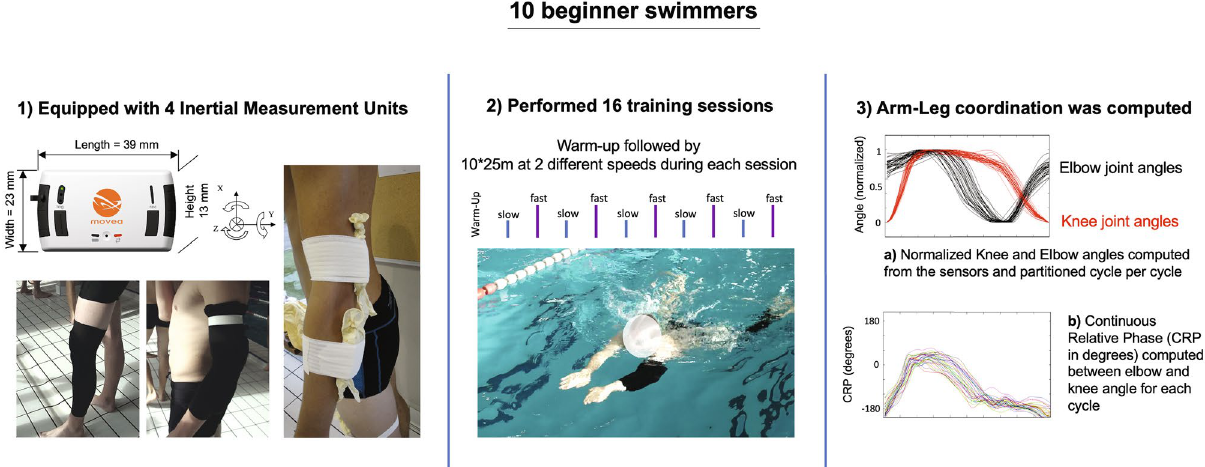
Figure 7. Experimental design. Overview of the experimental design followed by the 10 participants through 3 main steps: 1) material, 2) task, and 3)